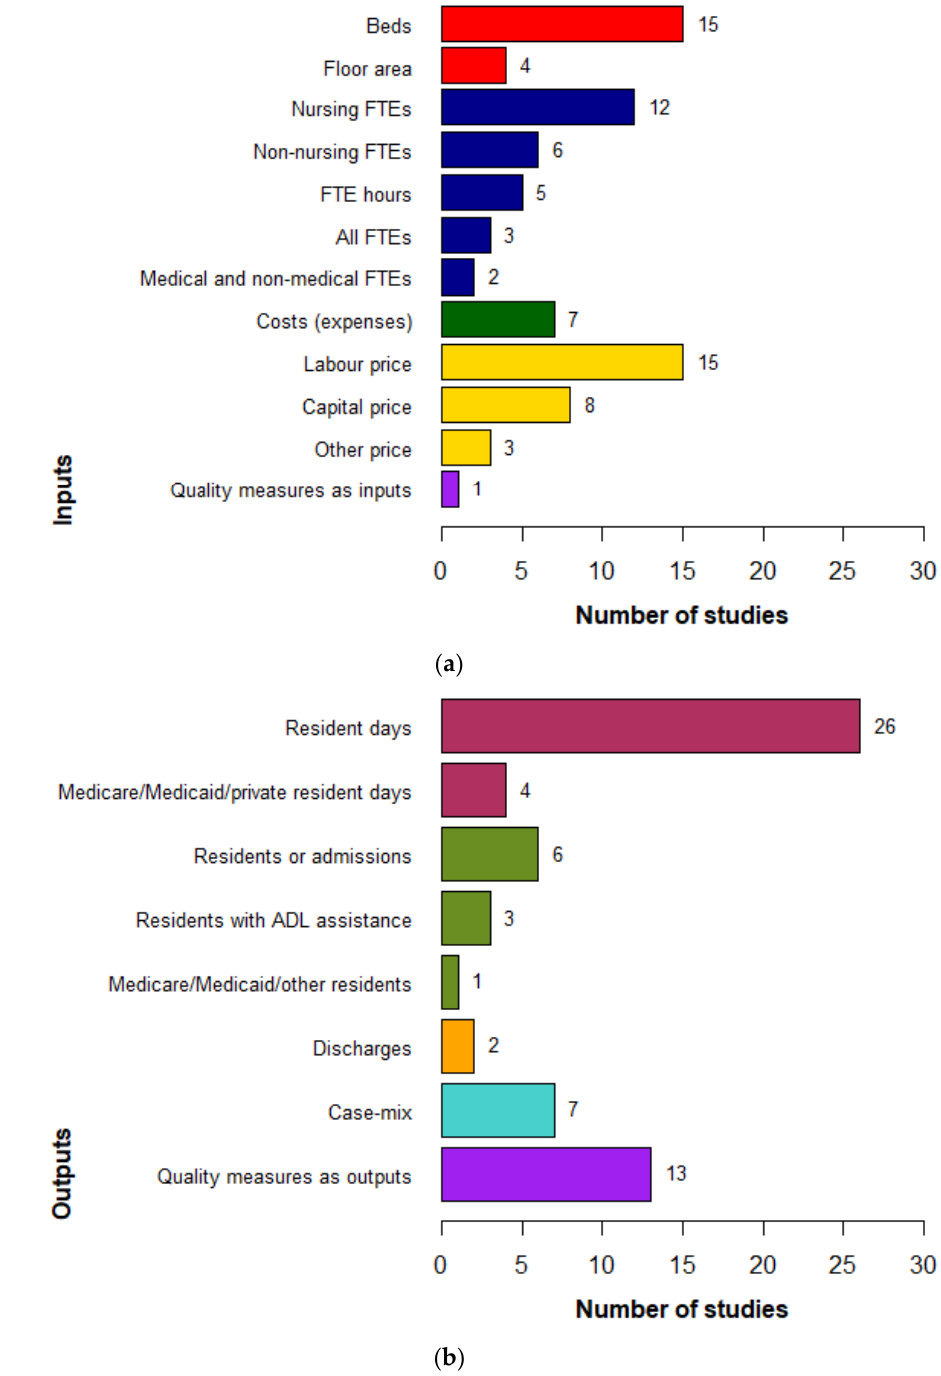
Figure 2. Distribution of input and output measures in nursing home efficiency literature: ( a ) distribution of input measures; ( b ) distribution of input measures.